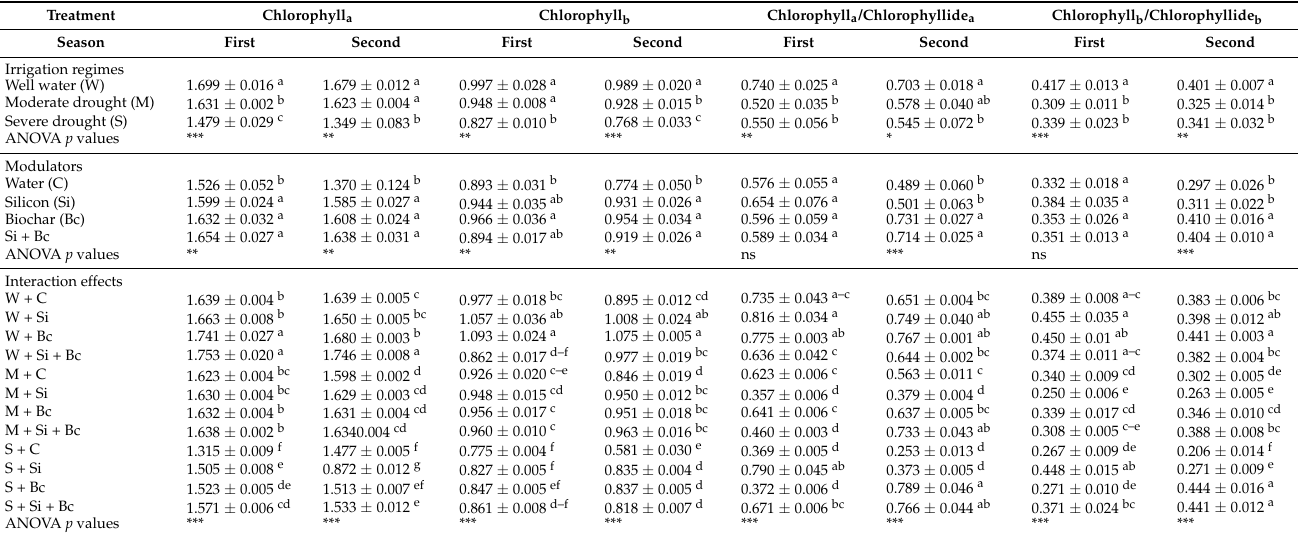
Table 6. Effect of irrigation regimes, silicon, biochar and their interaction on chlorophyll a and chlprophyll b concentration (mg g − 1 FW) as well as the ratio of chlorophyll a /chlorophyllide a and chlorophyll b /chlorophyllide b of borage plants throughout two experimental